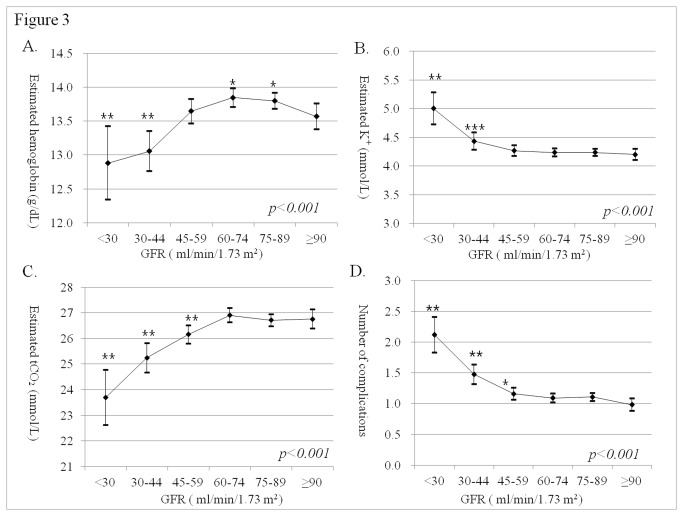
Estimated hemoglobin level (A), serum potassium level (B), total CO2 level (C), and number of complications (D) according to GFR group at basal examination by ANCOVA.*p < 0.05, different from GFR group 1; **p < 0.05, different from other GFR groups; ***p < 0.05, different from GFR groups 1, 2, and 3. The level of hemoglobin was adjusted by age; sex; SBP; DBP; number of anti-hypertensive medications; ferritin deficiency; presence of anti-HBV surface antibodies; levels of serum albumin, alanine aminotransferase, bilirubin, gamma-glutamyl transferase, cholesterol, triglyceride, CRP, and HbA1c; TIBC saturation rate; activated prothrombin time; and WBC count. The level of serum potassium was adjusted by age; sex; levels of serum bilirubin, thyroxin 4, and LDH; and TIBC saturation rate. The level of total CO2 was adjusted by age, sex, and presence of proteinuria ≥ 1+. The number of complications was adjusted by age; sex; SBP; DBP; levels of glucose, albumin, alkaline phosphatase, alanine aminotransferase, gamma-glutamyl transferase, cholesterol, HDL-cholesterol, triglycerides; TIBC saturation rate; WBC and platelet count; and ESR.